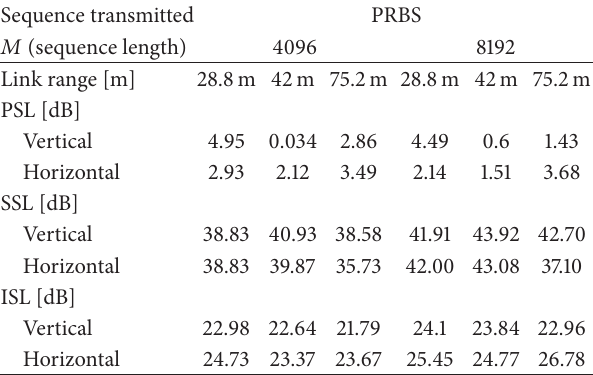
Table 3: Results for PSL, SSL, and ISL parameters—PRBS case.